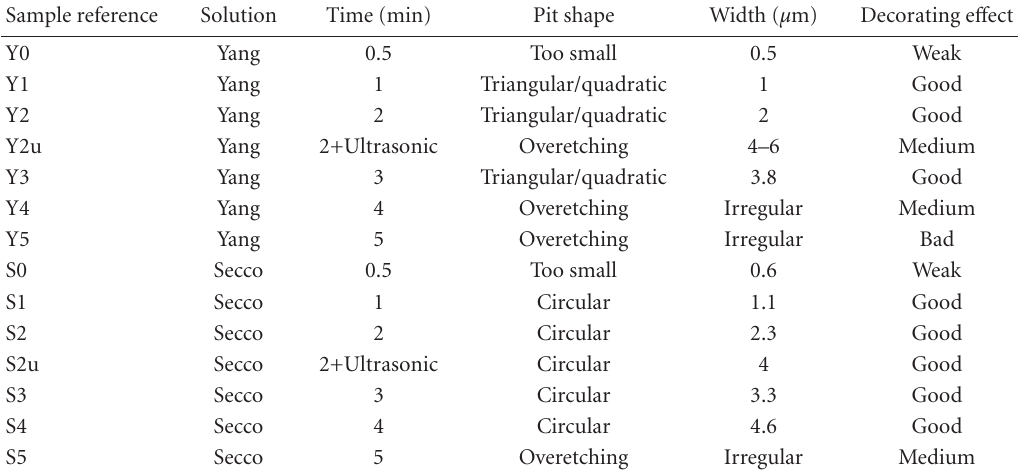
Table 1: Yang and Secco parameters e ff ects on etched dislocation pits of mc-Si samples. Sample